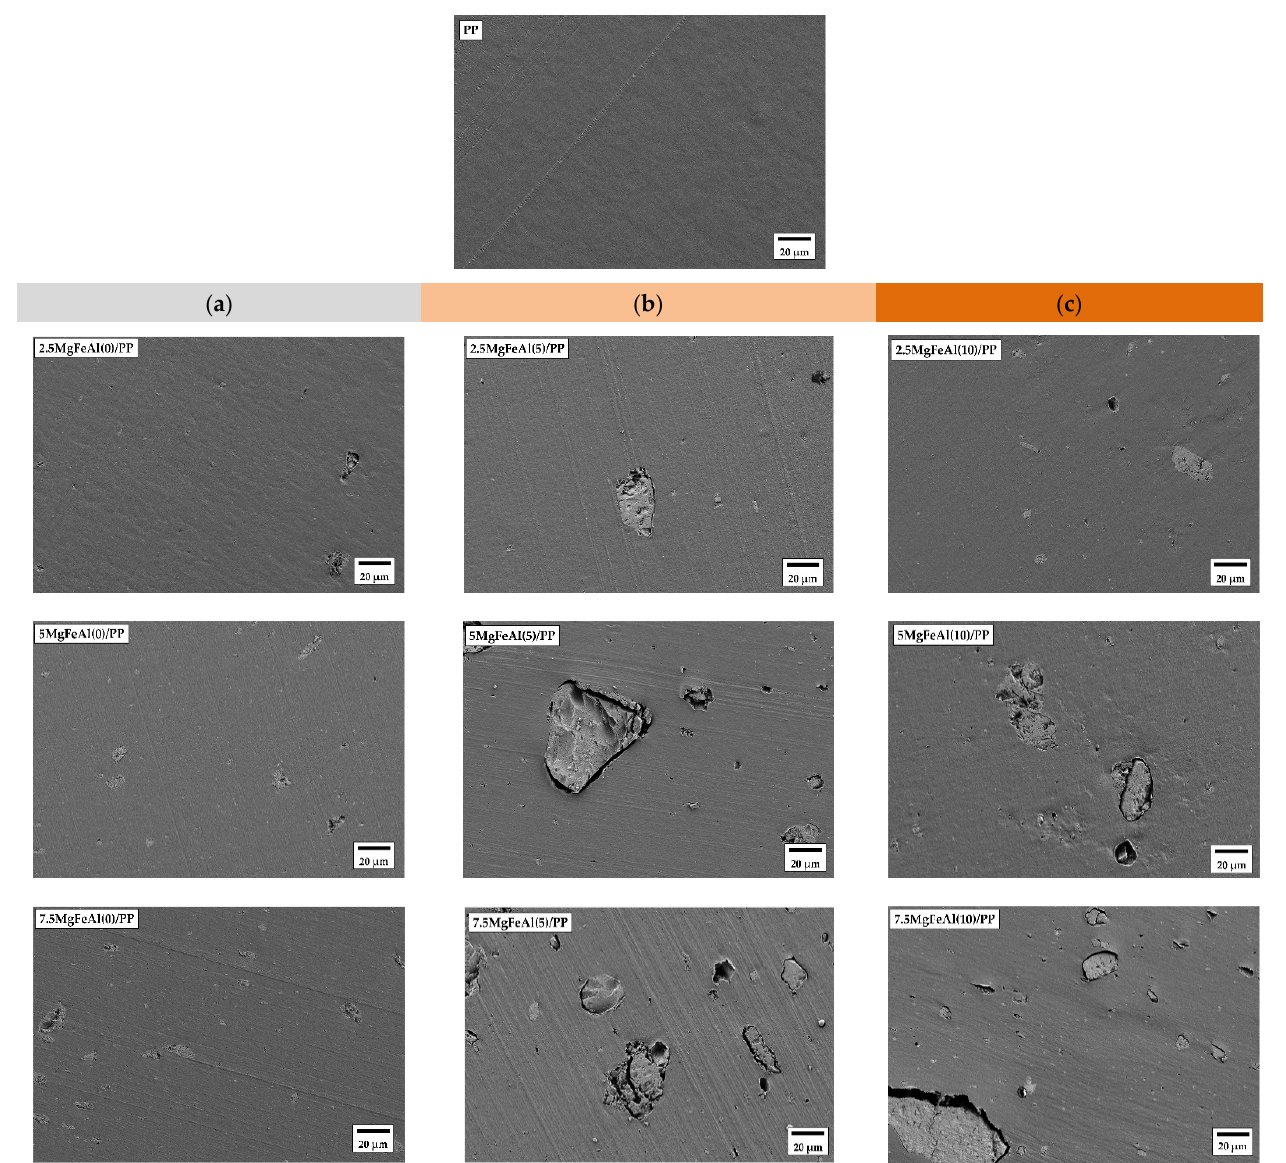
Figure 6. SEM images of pure polypropylene (PP), and ( a ) MgFeAl(0)/PP (2.5, 5, 7.5 wt %), ( b ) MgFeAl(5)/PP (2.5, 5, 7.5 wt %), ( c ) MgFeAl(10)/PP (2.5, 5, 7.5 wt %) nanocomposites.